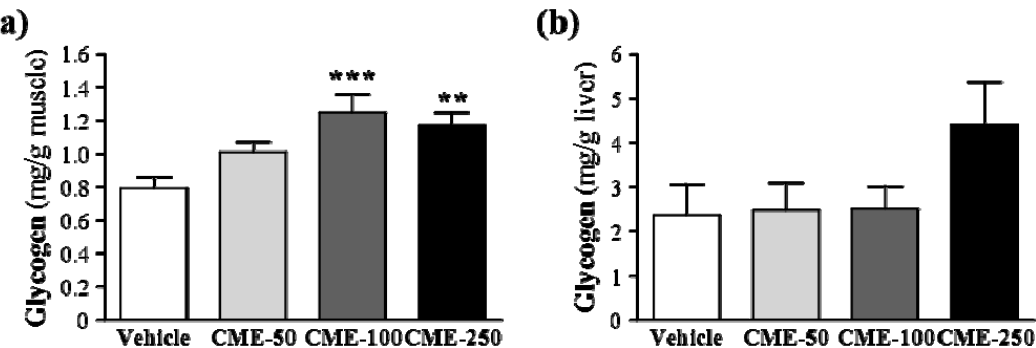
Figure 4. Effect of CME on ( a ) muscular and ( b ) hepatic glycogen levels at rest. Mice were pretreated with vehicle, 50, 100, and 250 mg/kg of CME for 14 days, all mice were sacrificed and examined for glycogen levels of muscle and liver tissues at 1 h after last treatment. Data represent mean ± SEM of 8 mice in each group. * p < 0.05; ** p < 0.01, *** p < 0.001 compared to vehicle